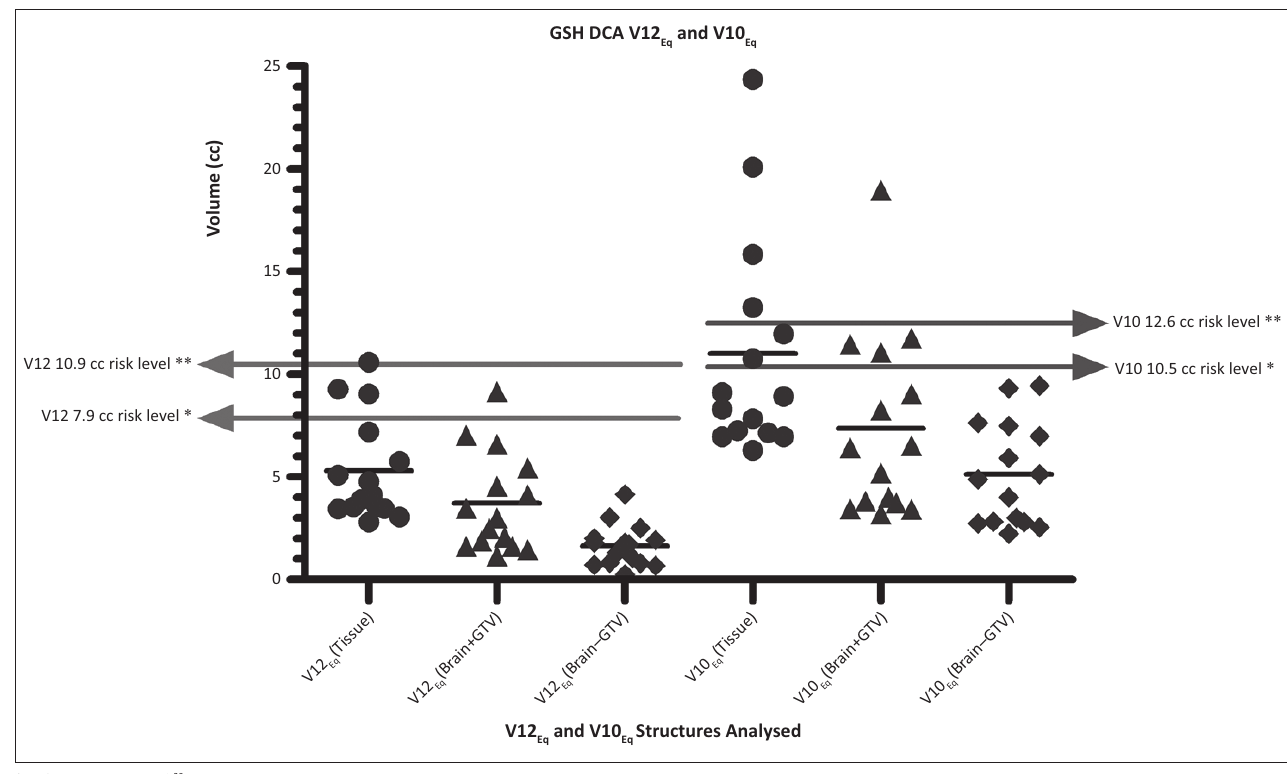
FIGURE 4: Volume of tissue, brain (including gross target volume) and unaffected brain (excluding gross target volume) receiving 12 Gy